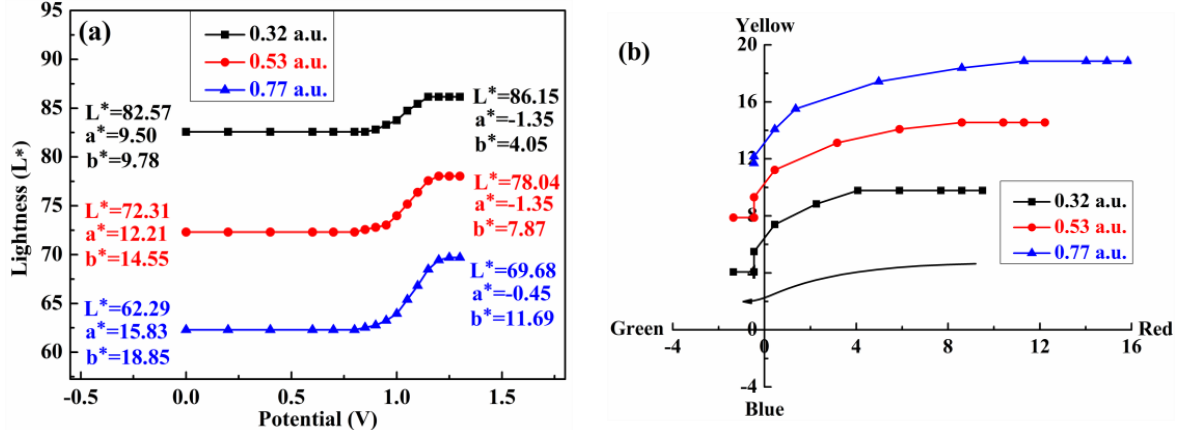
indicates black, and a value of 100 indicates white-positive) and a* and b* express red and yellow, respectively, while the negative values represent blue and green, respectively.